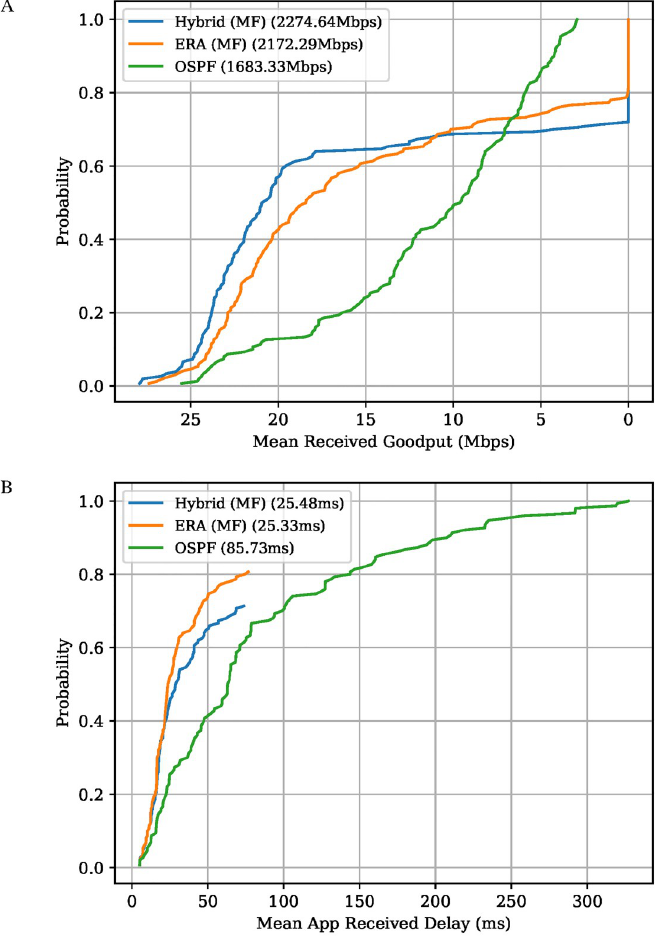
Fig 10. Network performance comparison between the ERA and Hybrid algorithm. MF refers to the solution with the highest network flow value. A: Probability that a flow achieves at least a given average Received Goodput in Mbps, in simulation. The total received Goodput achieved by each algorithm is shown in parentheses. B: Probability that a flow experiences at most a given average end-to-end delay at the application layer, in simulation. The mean application delay achieved by each algorithm is shown in